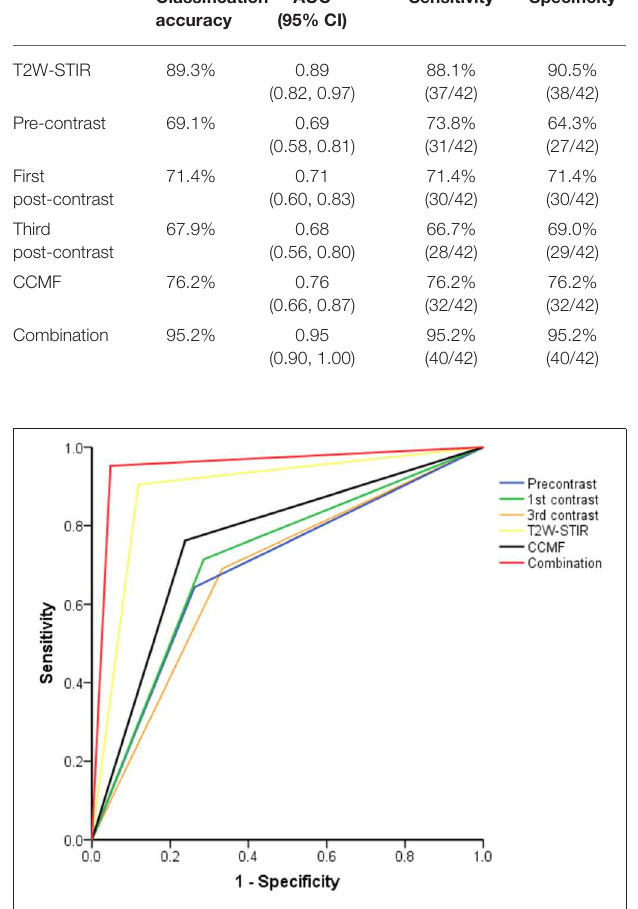
FIGURE 3 | The receiver operating characteristic curves from each approach for differentiation between phyllodes tumors and fibroadenomas.